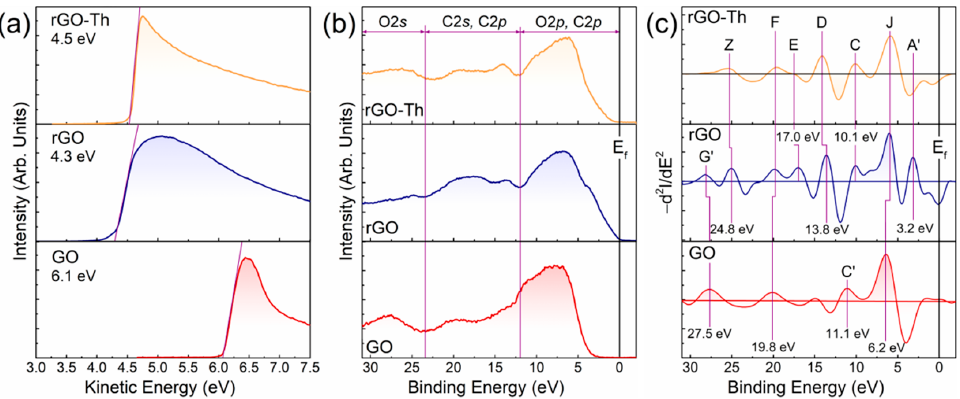
Figure 5. Analysis of the electronic structure of rGO–Th compared to other CMGs. ( a ) Cut-off SE spectra of the initial GO, rGO, and rGO–Th. ( b ) VB spectra and ( c ) their second derivative ( − d 2 I /d E 2 ) of the CMGs under study.